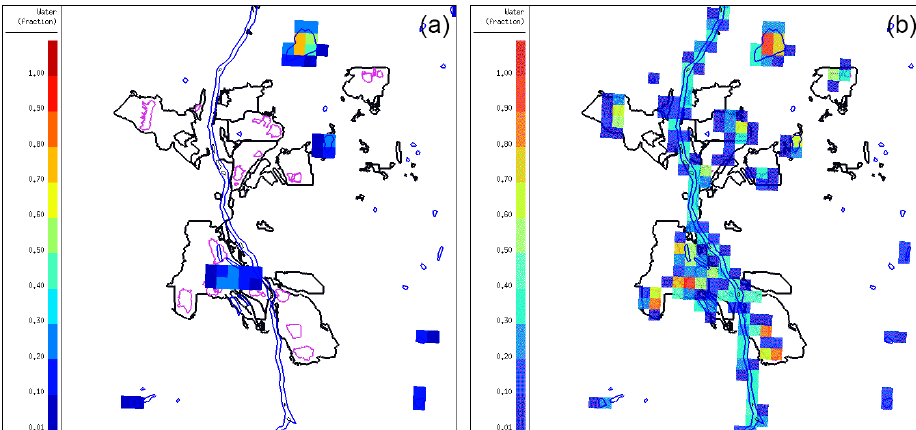
Figure 6. (a) Inland water coverage for a portion of the 2.5km OS grid centered on the six AOSR mining and processing facilities generated from the original land-cover database (only natural lakes); and (b) modified inland water coverage including tailings ponds and rivers. The black and pink lines in panel (a) indicate the cleared-land areas and the tailings ponds within the boundaries of the six AOSR mining and processing facilities, whereas the blues lines in panel (a) mark the boundaries of natural lakes and